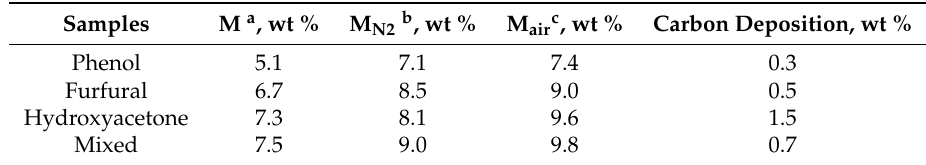
Table 5. BET surface area of the reduced and used catalyst. Model Compounds